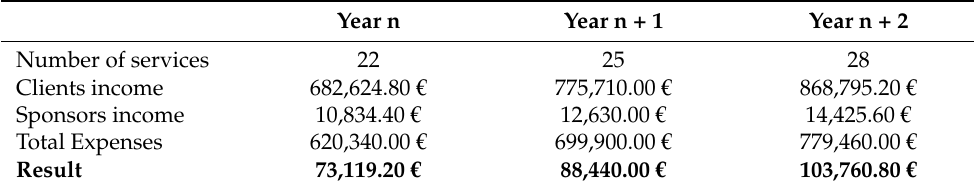
Table 16. Estimate of services, income and expenses in the following